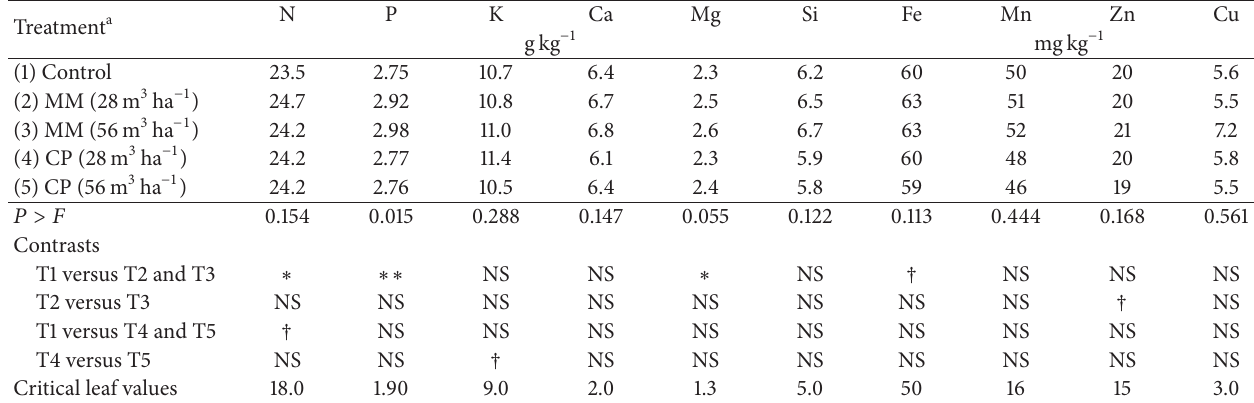
Table 8: Predicted least squares means, 𝑃 > 𝐹 , and significant contrasts for leaf nutrient concentrations for the first ratoon crop at Site 2. Critical leaf nutrient concentrations [19] are included for